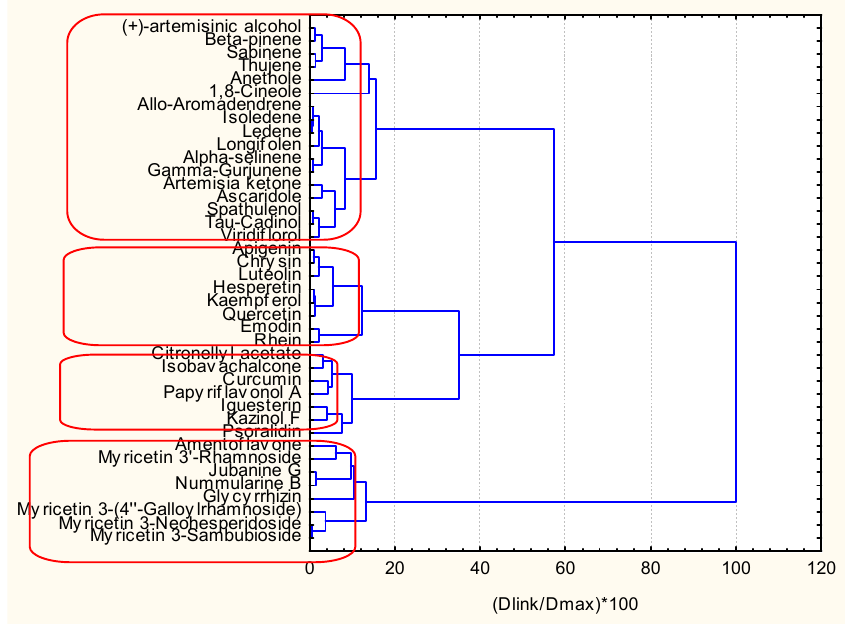
Figure 14. Hierarchical dendrogram for clustering of 40 objects.